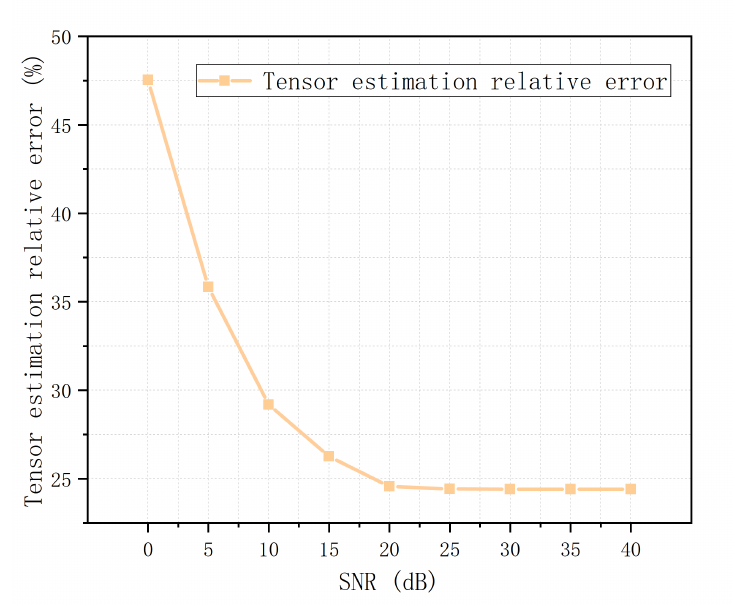
Figure 11. Estimation error of the magnetic polarizability tensor element of a cylindrical target at different SNR